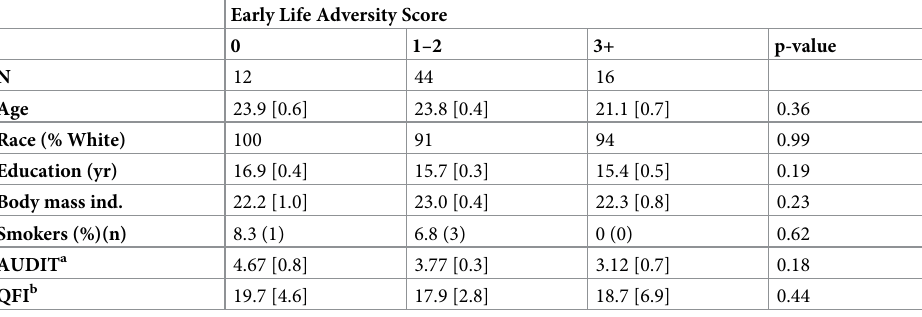
Entries show M ± SEM unless noted otherwise. P-values are for F tests on continuous variables and Chi square tests for the categorical variables, race, and percentage of smokers.